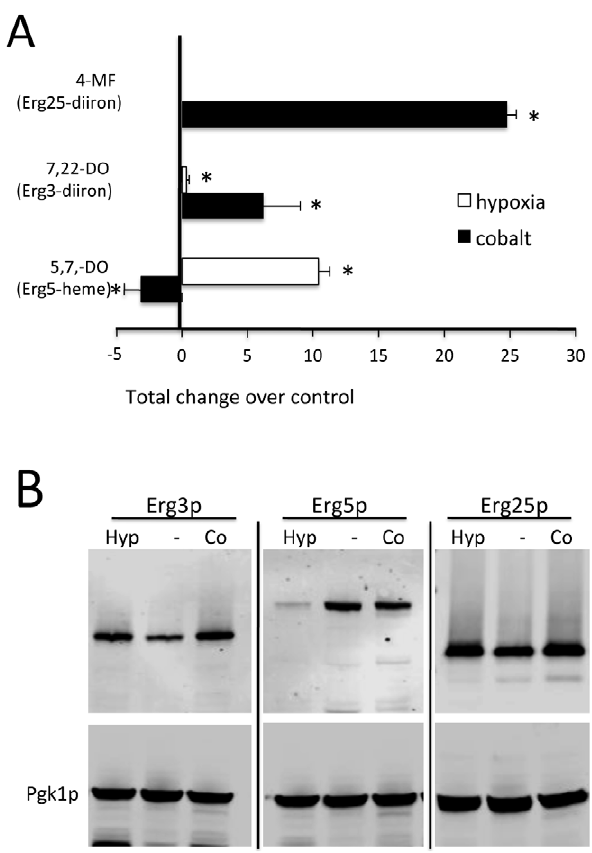
Figure 2. Effects of cobalt and hypoxia on sterol biosynthetic enzymes Erg3p, Erg5p and Erg25p. Cells grown in minimal medium as in Fig. 1 were analyzed for sterol metabolites and expression of sterol biosynthetic enzymes. A) Byproducts from blocks in enzymatic steps for S. cerevisiae Erg25p, Erg3p and Erg5p are indicated. The arbitrary units shown represent the quantity of metabolite detected by GC/MS above that of control untreated samples which =0 (undetect- able) in the case of 4 methyl fecosterol (4-MF) and ergosta 7,22-dien-3B- ol (7,22-DO). Control untreated samples had a small level of ergosta 5,7- dien-ol (5,7-DO) which was increased with hypoxia, but decreased with cobalt treatment as depicted by the negative value. B) Cells expressing TAP tagged versions of the indicated proteins were analyzed by immunoblot using an antibody directed against TAP. Blots were also probed with anti-PGK1 as a control. Shown are expression levels of TAP tagged-Erg3p (63.7 kDa), Erg5p (82.3 kDa) and Erg25p (57.5 kDa). ‘‘Hyp’’, hypoxia treated; ‘‘ 2 ‘‘, control; ‘‘Co’’, cobalt. Results are representative of two (Erg25p) and three (Erg3p and Erg5p) experi- mental